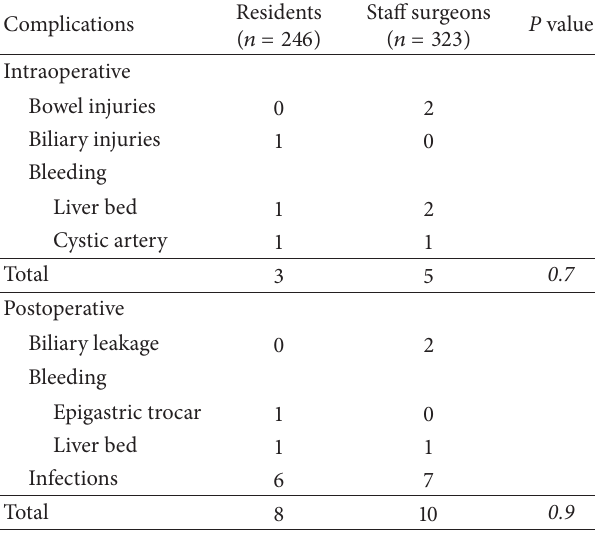
Table 2: Intraoperative and postoperative complications of the patients operated by residents and staff surgeons.